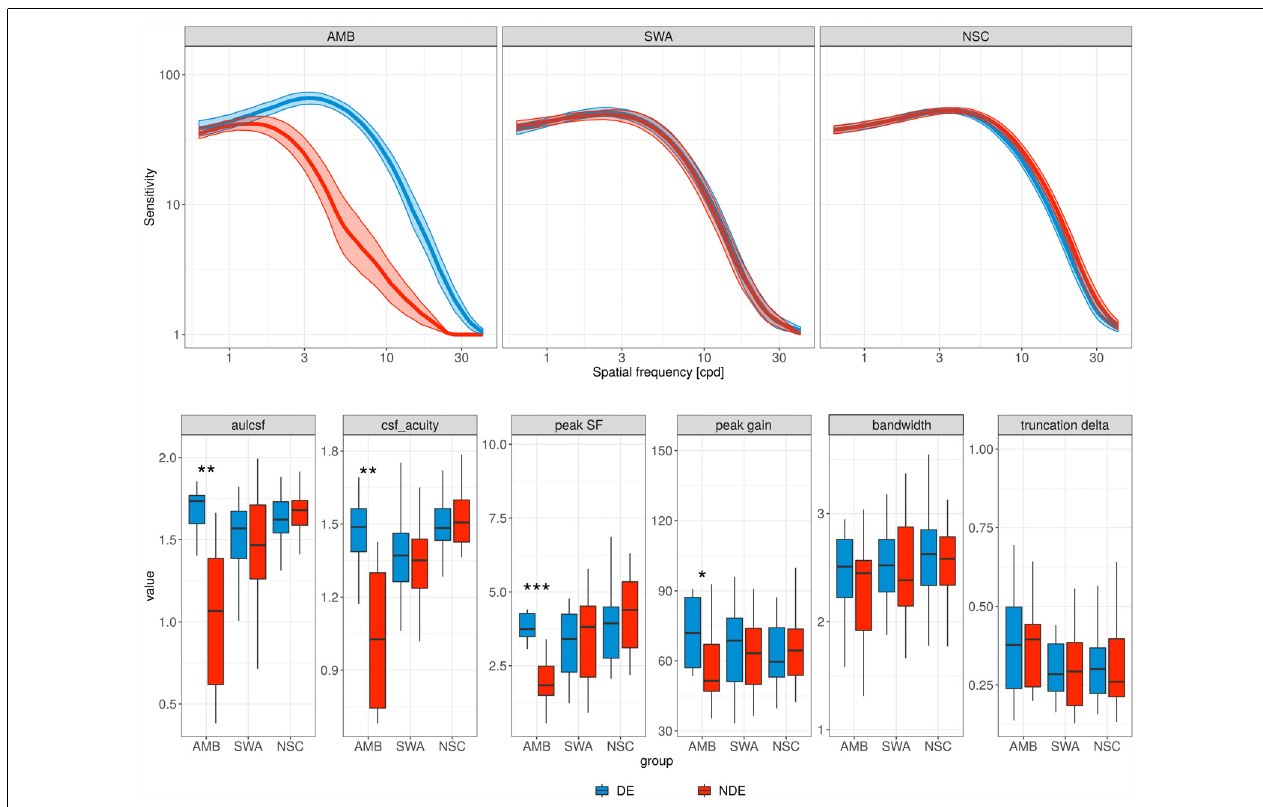
FIGURE 1 | Contrast sensitivity functions (CSFs). Top row, each panel contains the mean CSF of the non-dominant eye (red curve) and the dominant eye (blue curve) for the different subject groups. AMB, amblyopia; SWA, strabismus without amblyopia; NSC, normally sighted controls. Shaded areas represent ± 1 standard error of the mean (SEM). Bottom row, parameter distributions of the observed CSFs. Boxplot midlines indicate median values; “ ∗ ”, “ ∗∗ ,” and “ ∗∗∗ ” denote statistical significance (two-sided Wilcoxon test) at the alpha level of 0.05, 0.01 and 0.001, respectively.